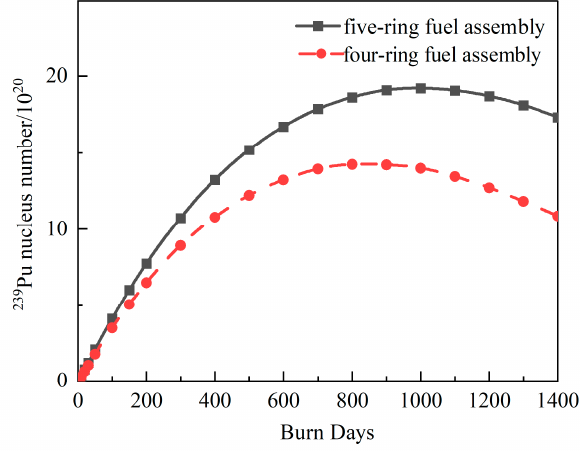
Figure 5. Variation in 239 Pu nucleus number with burnup.